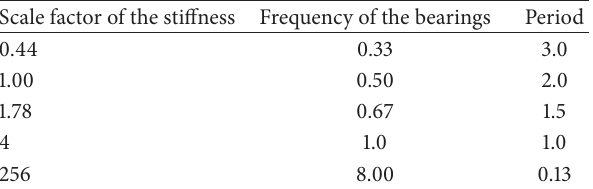
Table 1: Scaled horizontal equivalent stiffness of the bearings. Scale factor of the stiffness Frequency of the bearings Period